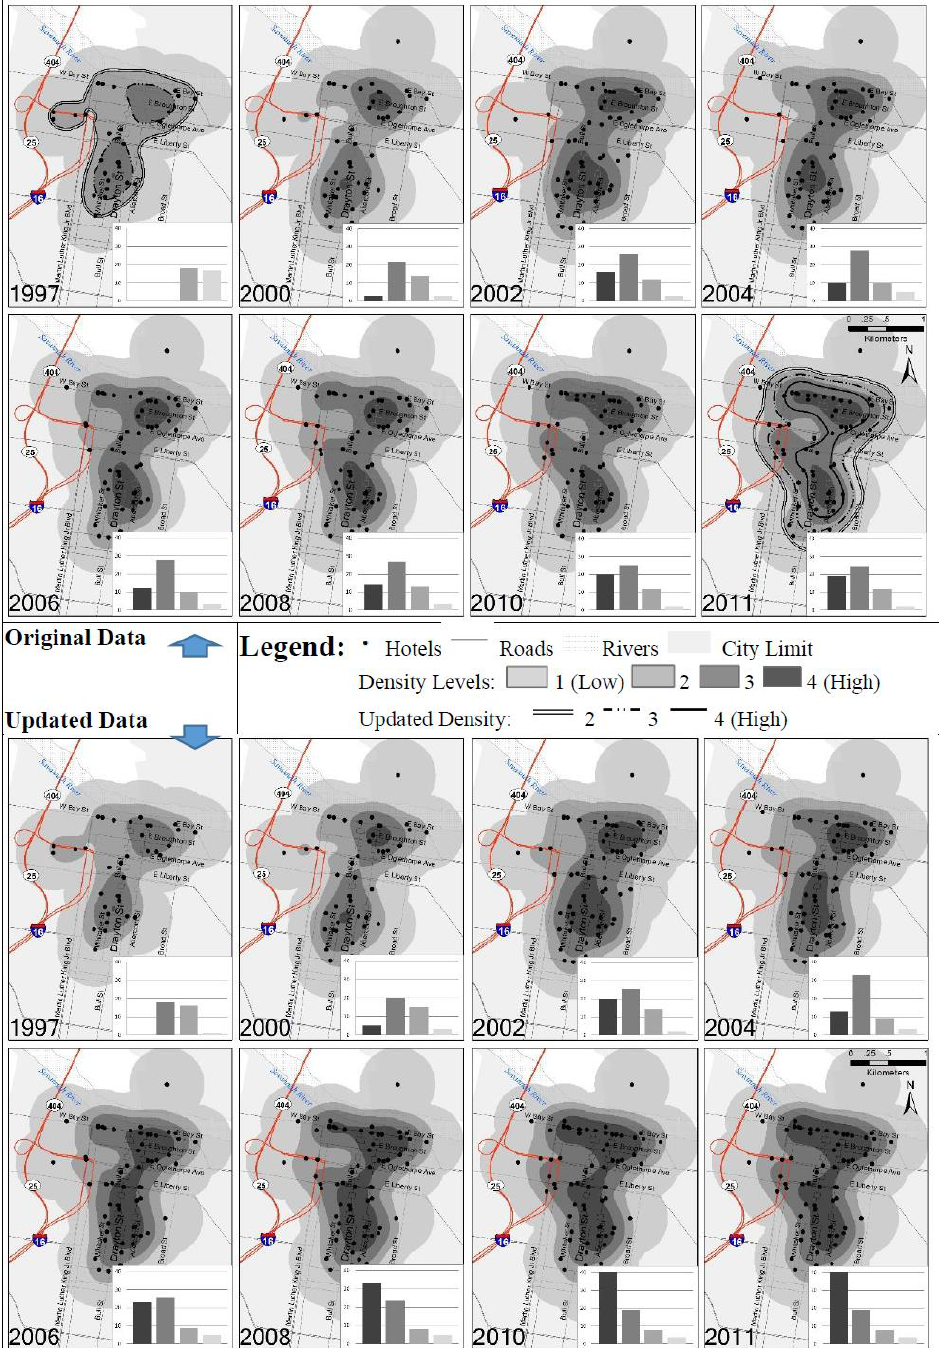
Figure 6. Kernel density of hotels: Original vs. updated (Savannah, GA, USA).